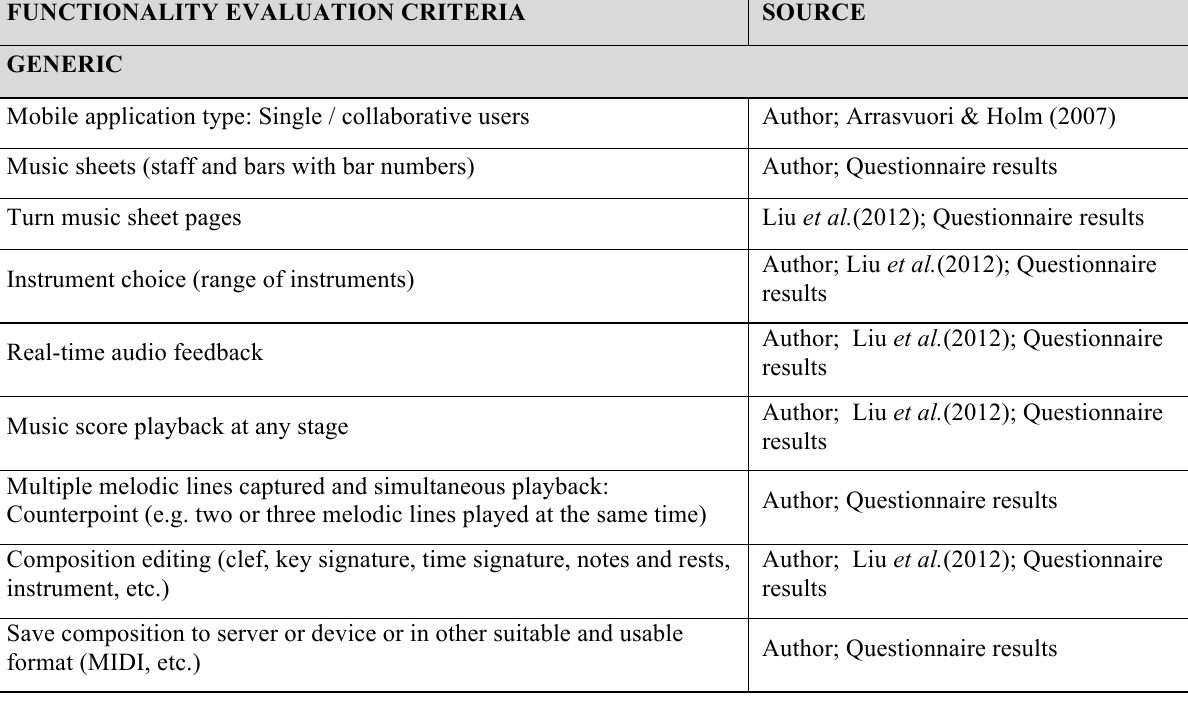
Table 4.1: A framework to evaluate mobile application functionality for music